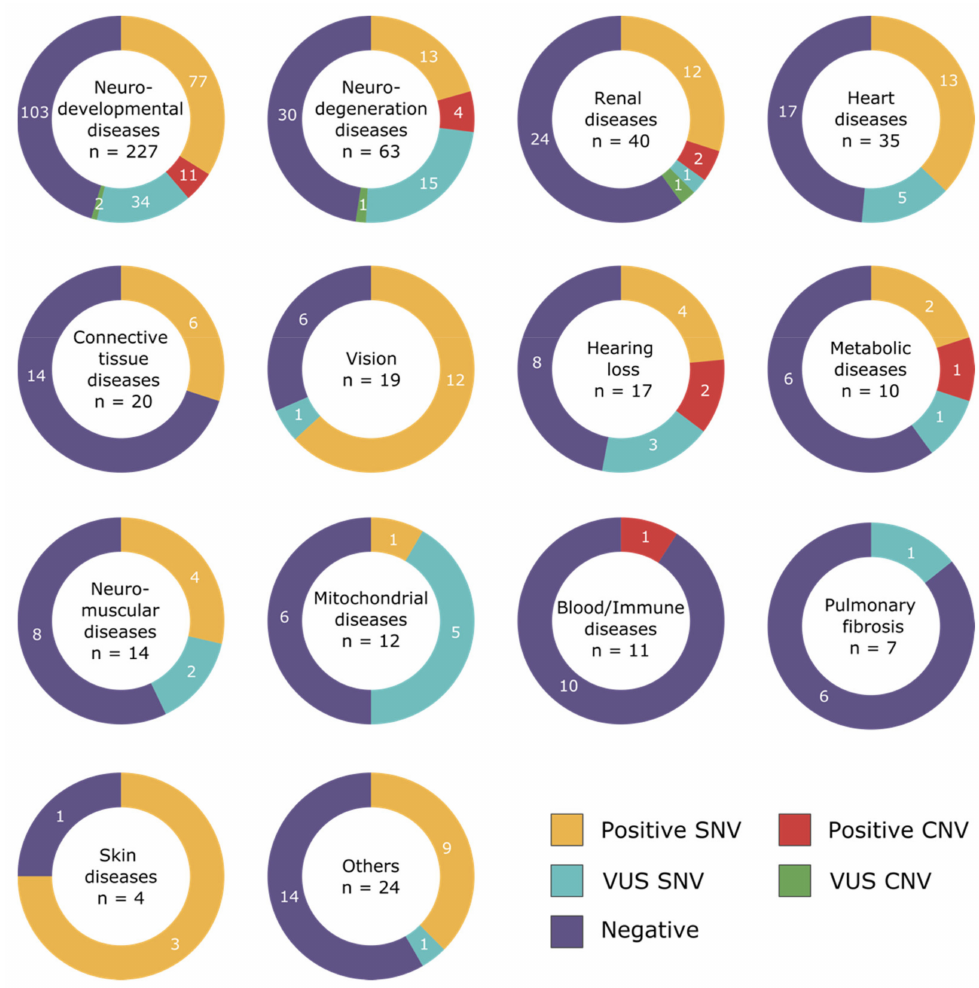
Figure 2. Diagnostic yield per disease category (some patients have multiple categories analysed),—patient positive with compound heterozygous SNV and CNV affecting the same gene ( n = 1) is included in the category “Positive